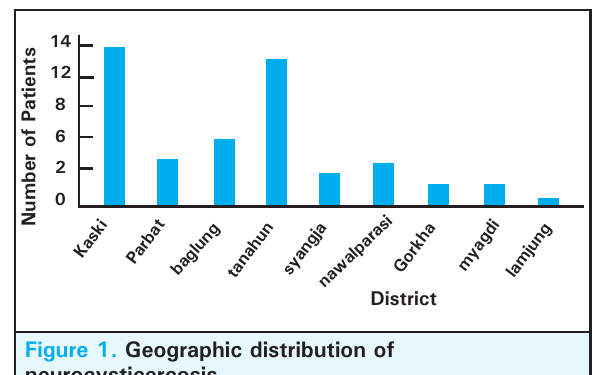
Figure 1. Geographic distribution of